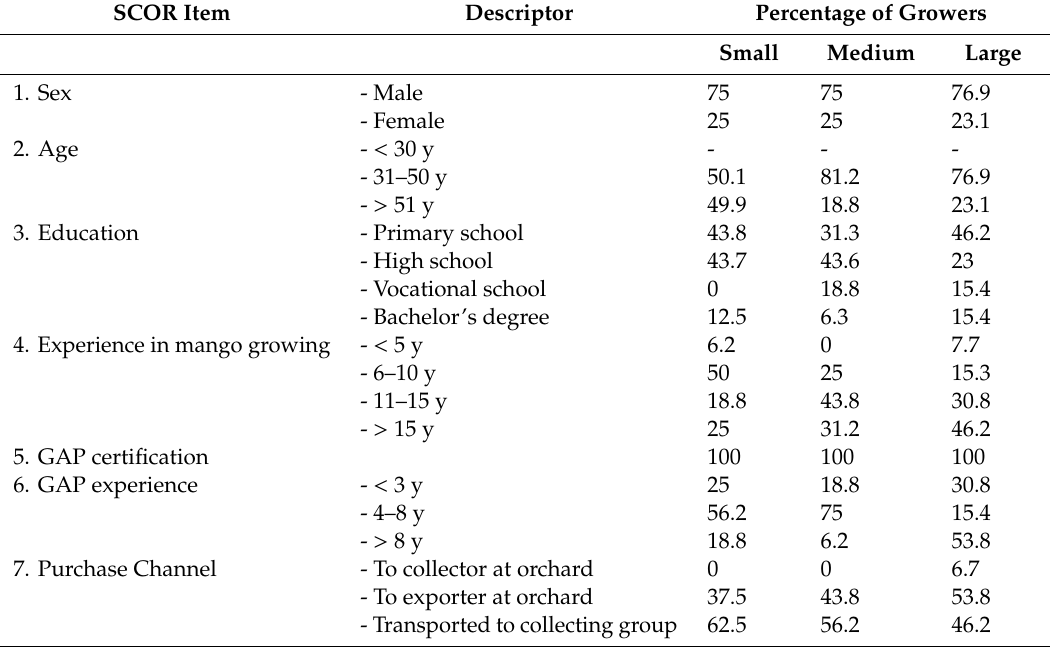
Table 1. General information regarding interviewed growers with different farm sizes followed by the supply chain operation reference ( SCOR ) model .